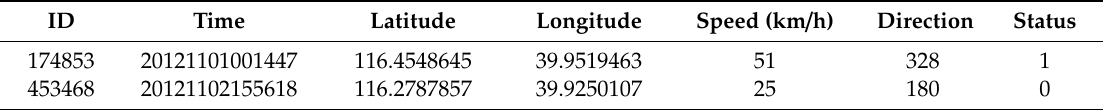
Table 3. Global Positioning System (GPS) dataset information.